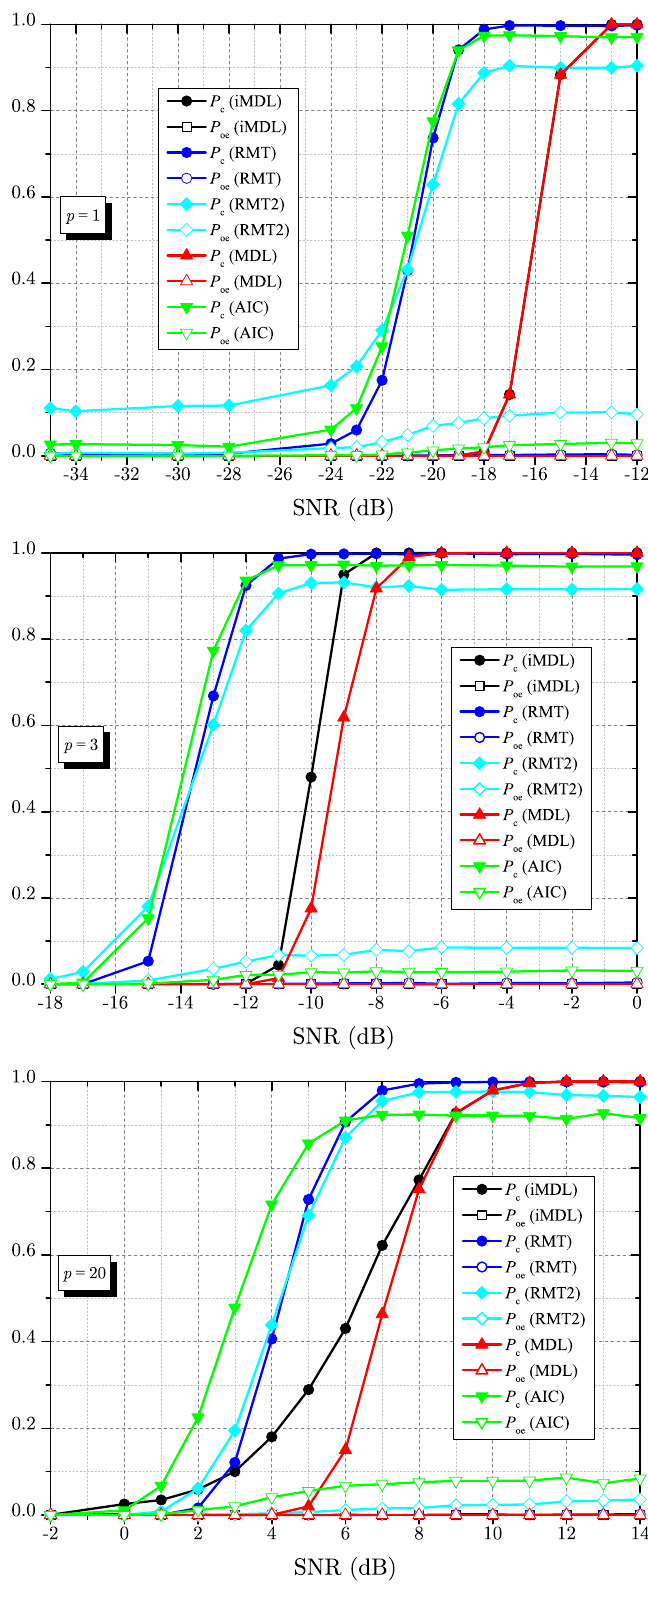
Figure 4. P and P against SNR for m = 30 , n = 1000 , p = 1 ( top ); p = 3 ( middle ) and c oe p = 20 ( bottom